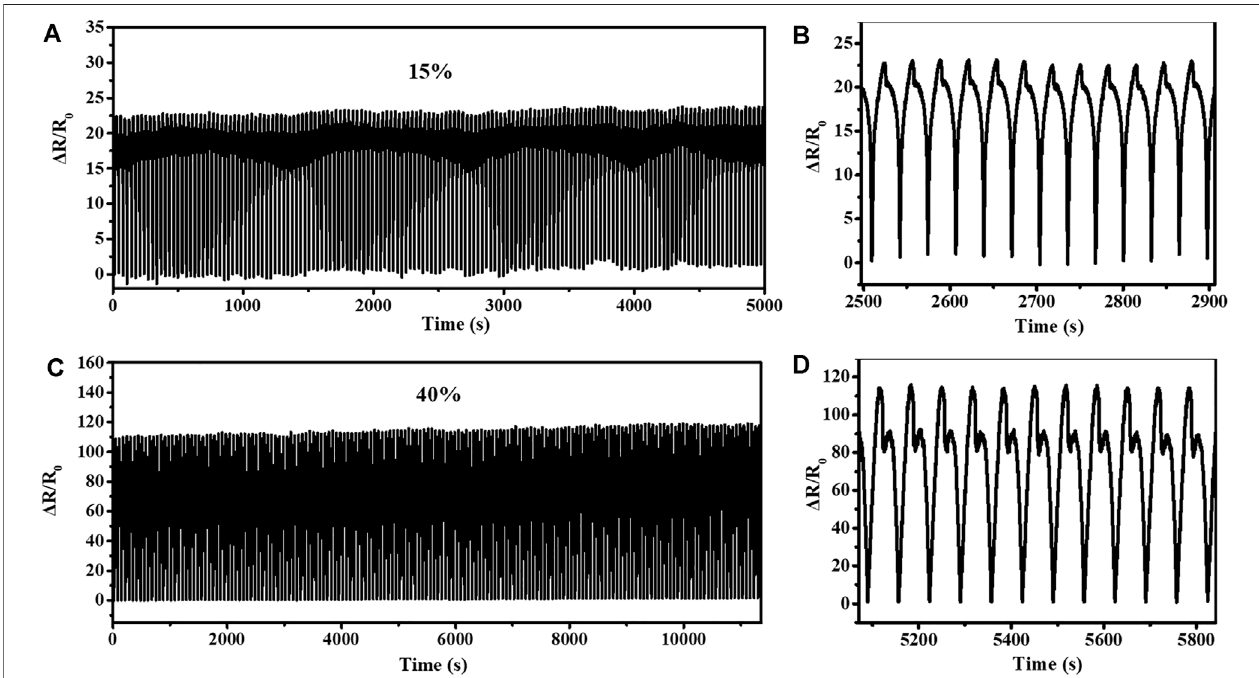
FIGURE 4 | (A) Multicycle operation of the strain sensor under 15% strain, (B) the magni fi ed cycles of the stretching test results, (C) multicycle operation of the strain sensor under 40% strain, and (D) the magni fi ed cycles of the stretching test results.